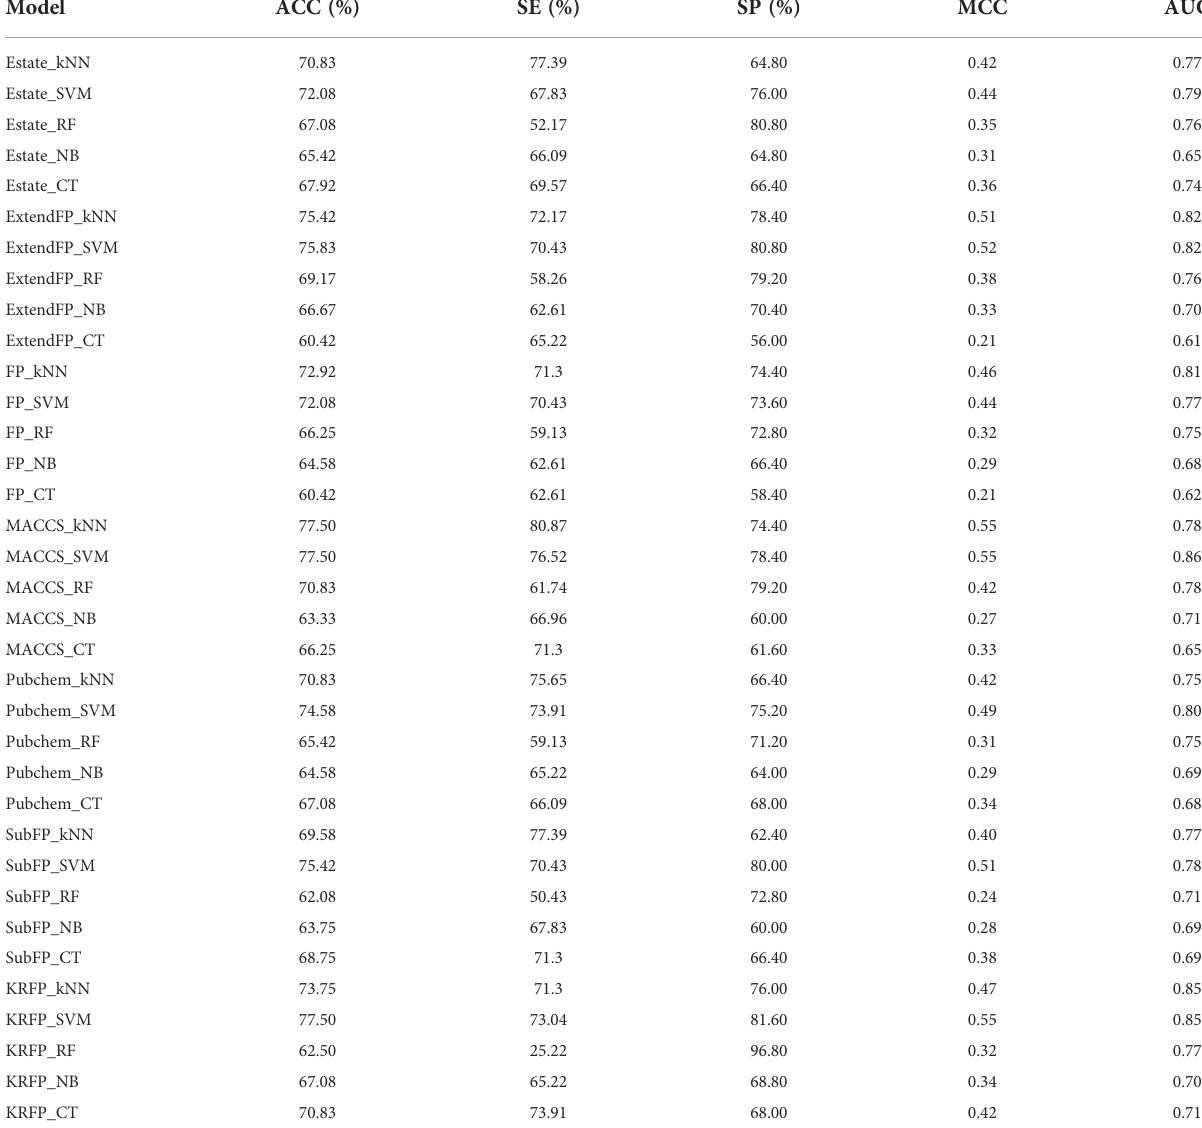
TABLE 2 Performances of models on 5-fold cross-validation.